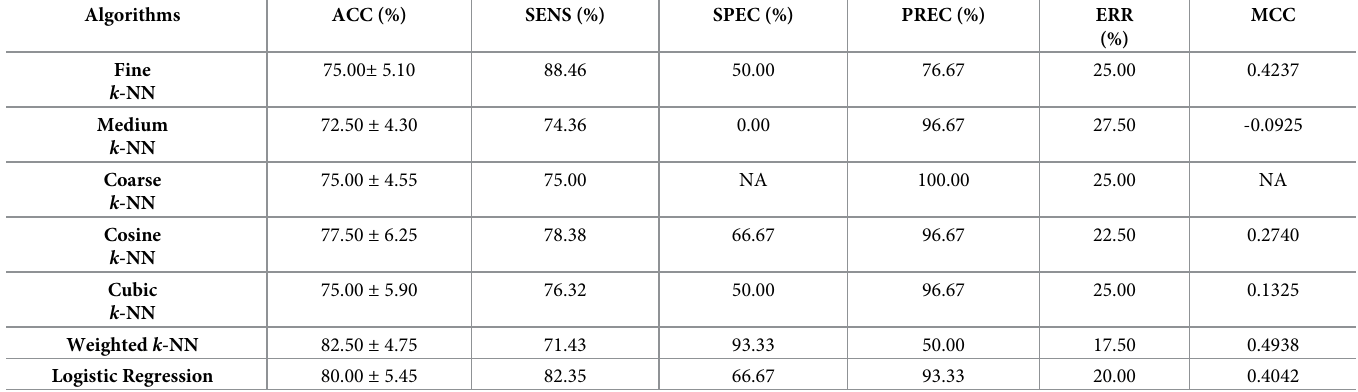
Table 3. The performance evaluation of the variation of k -NN algorithms and logistic regression.